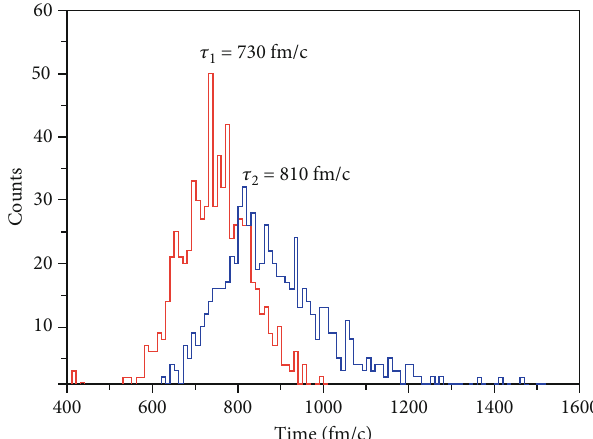
Figure 5: The distribution of the fi ssion moment in sequential ternary fi ssions of 197 Au+ 197 Au system at b = 7 fm. The red line is the primary fi ssion moment, and the blue line is the second breakup moment.